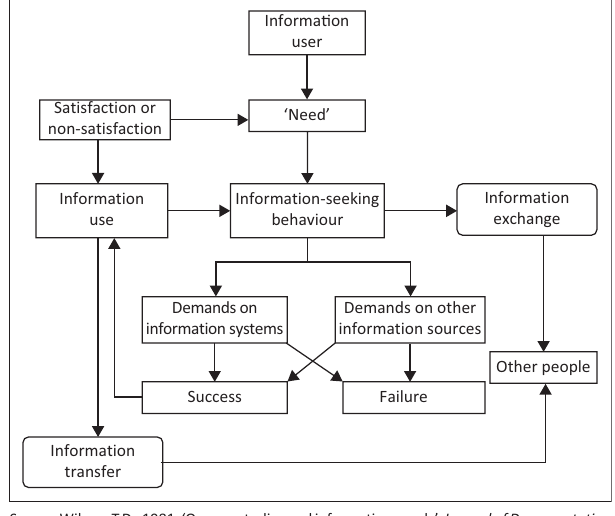
FIGURE 1: Wilson’s (1981) information behaviour